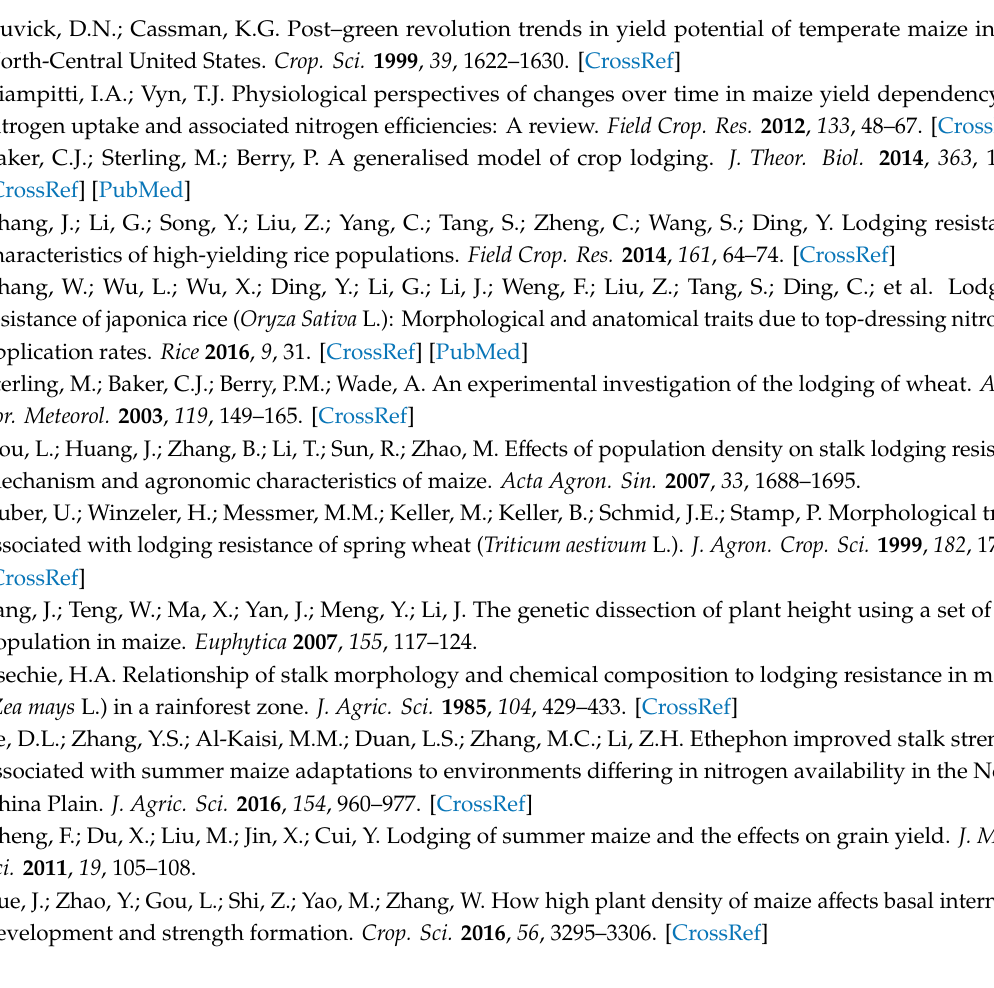
Table S1: Changes in the length of the seventh and ninth internodes; Table S2: Distribution of miRNAs at di ff erent stages of internode elongation; Table S3: Relative expression of miRNAs identified in this study; Table S4: Predictive target genes of di ff erentially expressed miRNAs; Table S5: GO analysis for predictive targeted genes of di ff erentially expressed miRNAs; Table S6: Identification and analysis for target genes of internode elongation related miRNA; Table S7: Detailed information of miRNA-mRNA-PPI